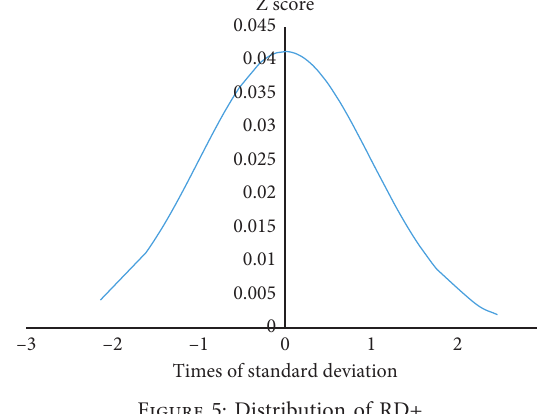
Table 7: Grading results of